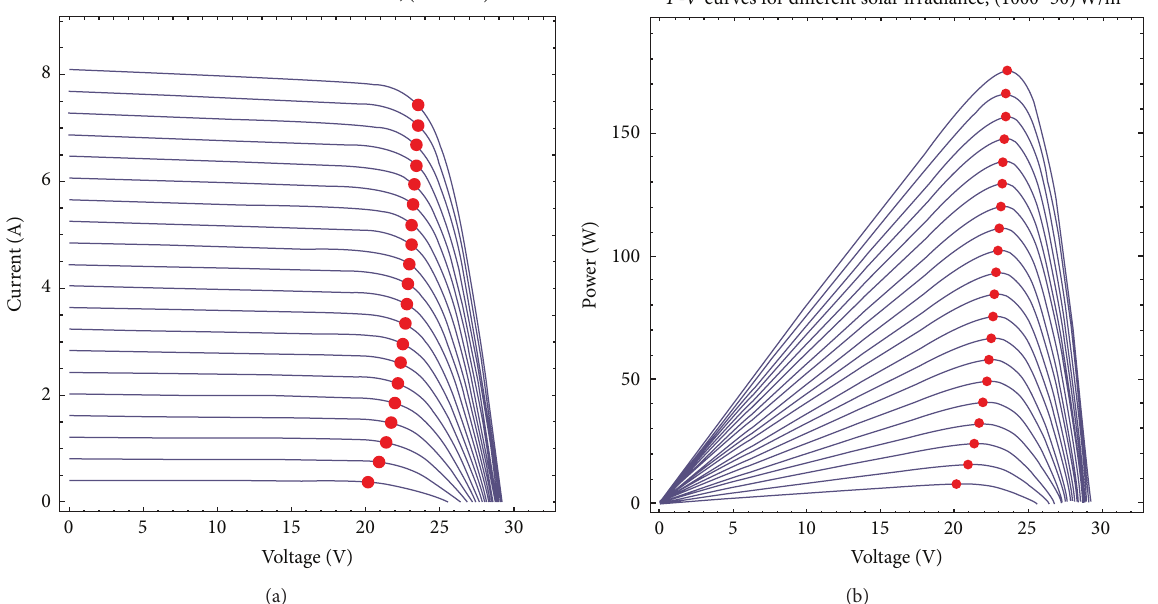
Figure 6: Position of maximum power points (red circles) of Kyocera KC175GHT-2 with variation of solar irradiance calculated with (4).